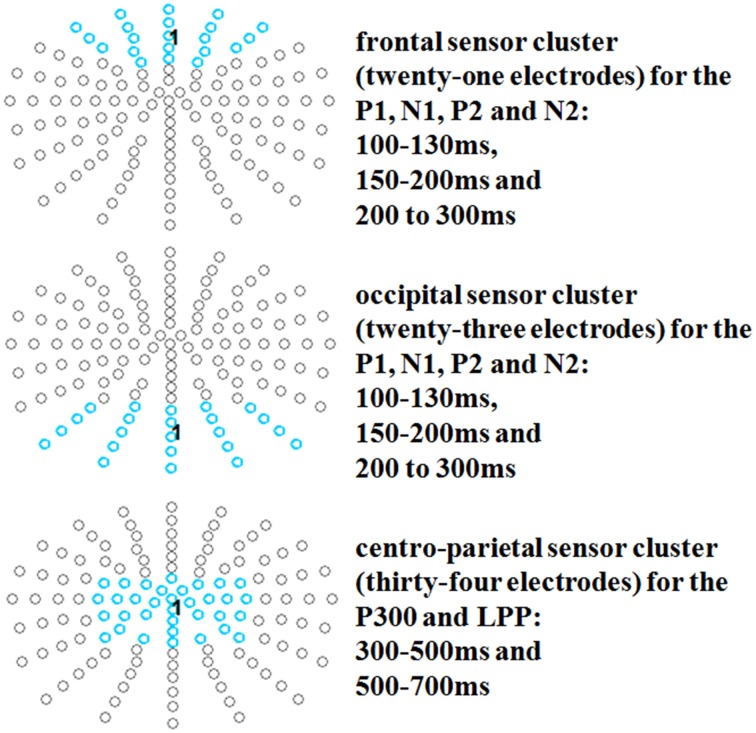
Selected electrode clusters for all time windows.